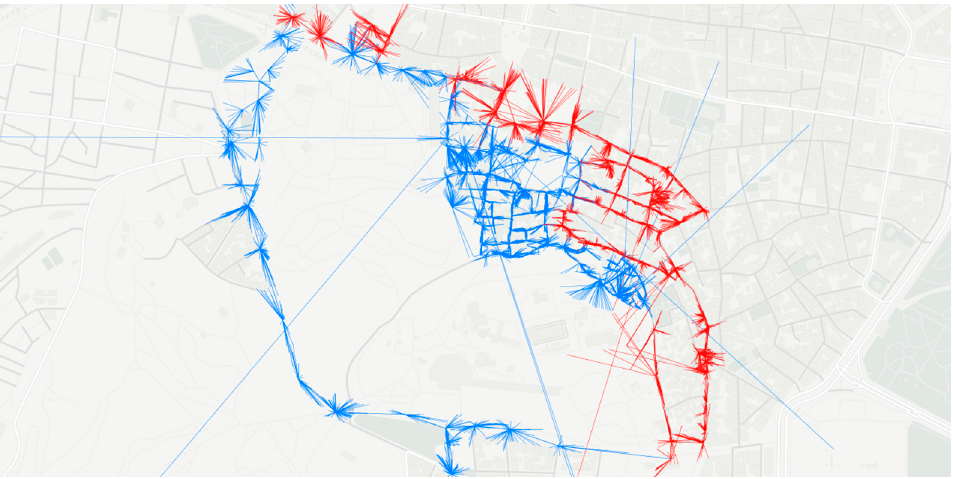
Figure 17. Network of observed features.